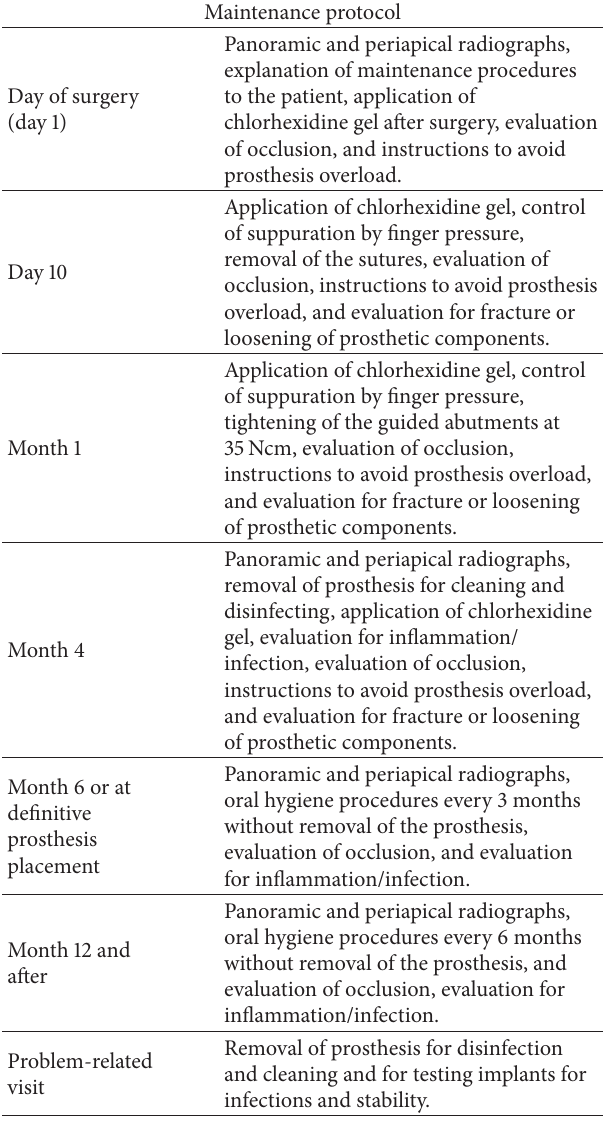
Table 2: Postsurgical maintenance protocol.